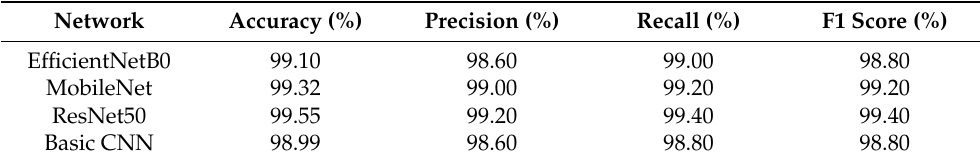
Table 5. Comparison of classification